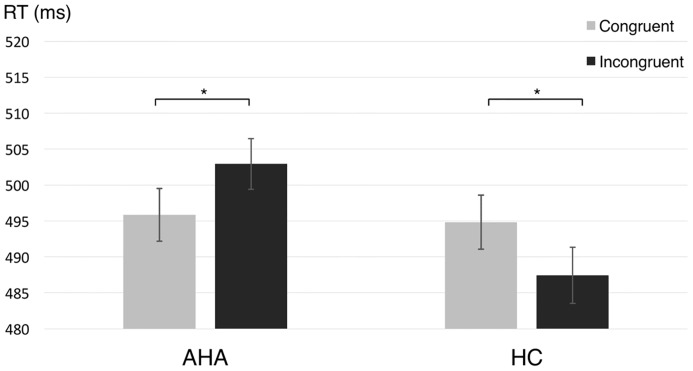
Reaction time (RT) for abstinent heroin addict (AHA) and healthy control (HC) groups in congruent and incongruent conditions, respectively. The reaction times (RTs) in the congruent condition, as compared to the incongruent condition, was significantly shorter for AHAs (p = 0.044) and significantly longer for HCs (p = 0.040). Error bars denote standard error. ∗p < 0.05.